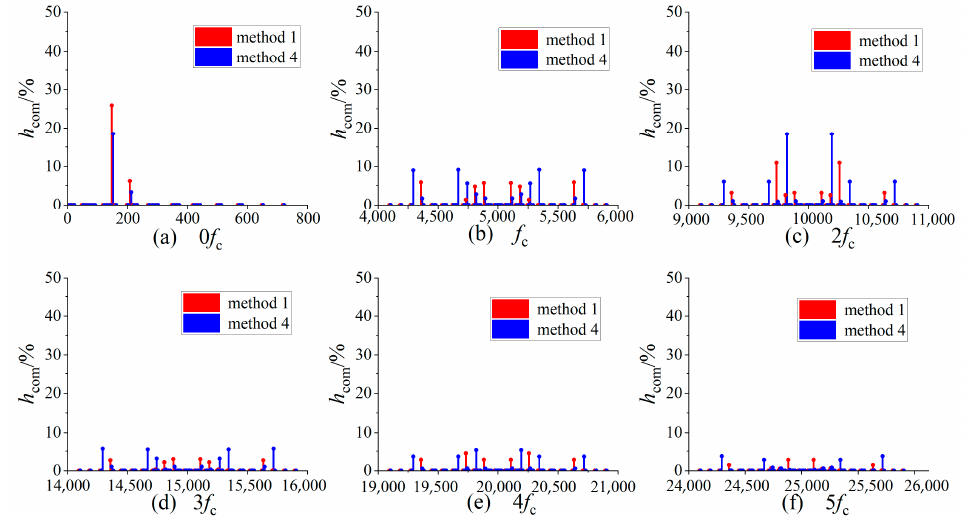
Figure 11. Partial enlargement of Figure 10. Table 3. Per-unit value of common-mode components at m =